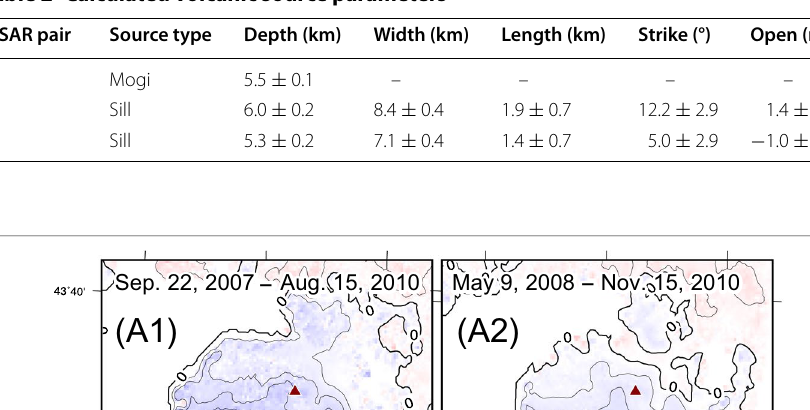
Table 2 Calculated volcanic source parameters